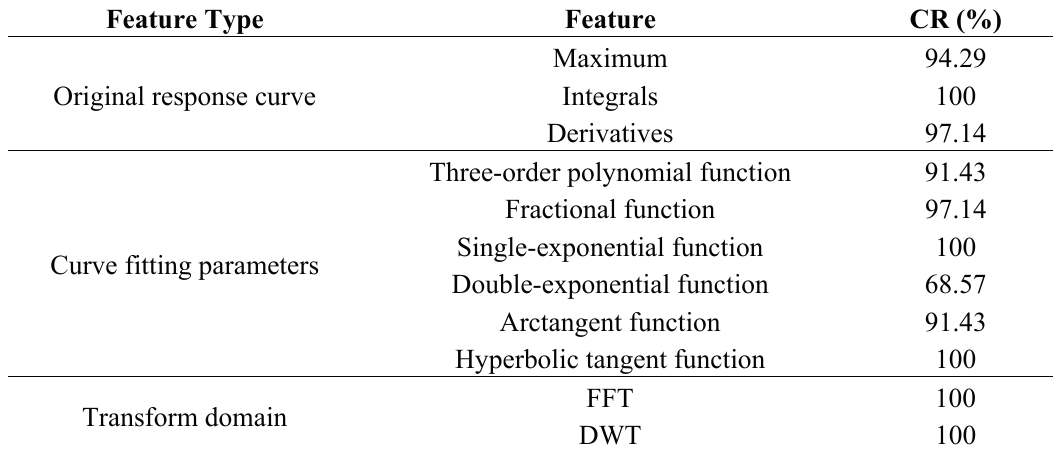
Table 10. Classification rates (CR) of three types of features in